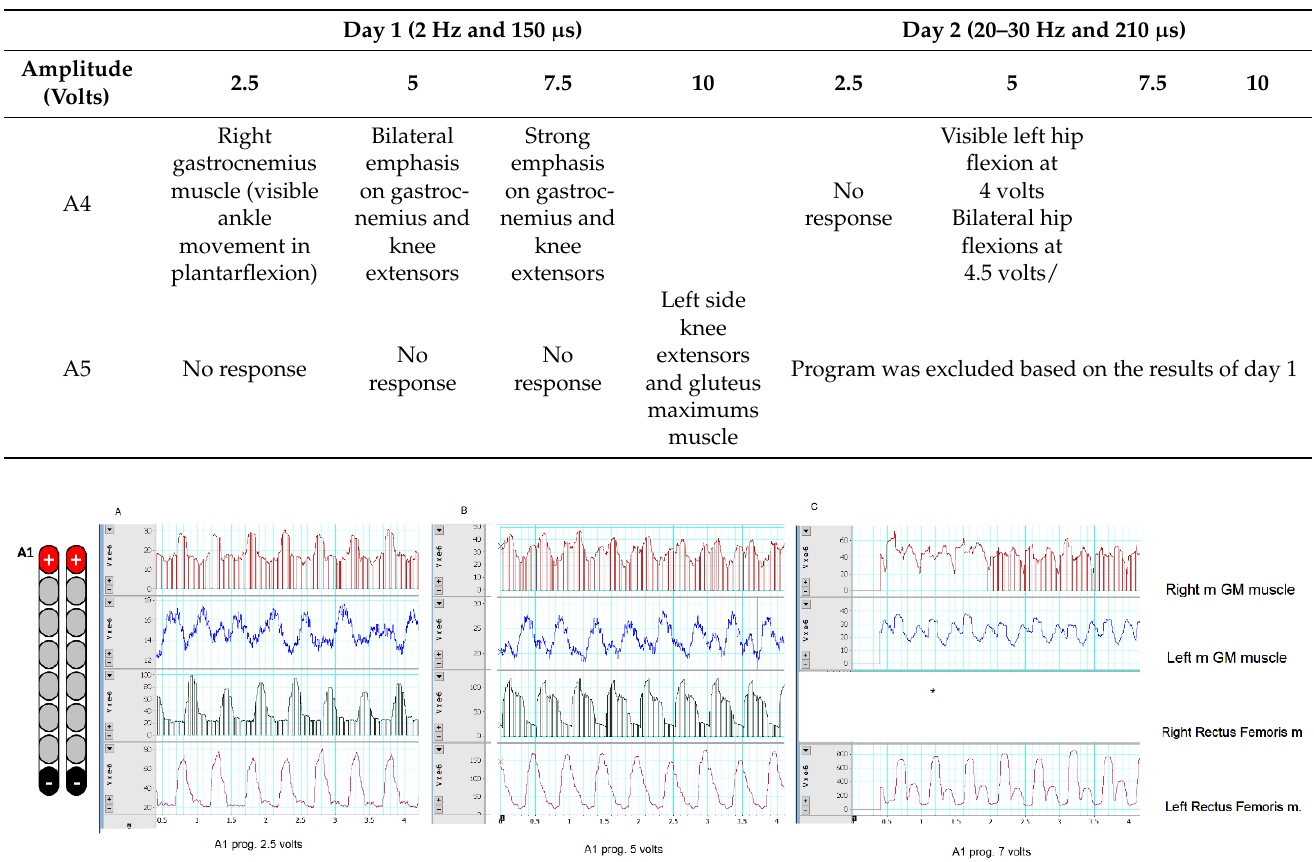
Figure 4. Representative EMG responses of rectus femoris (RF) m. and medial gastrocnemius (mGM) m. evoked by percutaneous scES. The EMG was tested at 2 Hz, 150 µs, and amplitude of current that progressed from 2.5 volts (visible EMG response without visible muscle contractions; ( A )), 5 volts (visible muscle twitches; ( B )), and 7.5 volts (strong visible twitches; ( C )). The EMG data were presented in a filtered format to highlight the distinct responses for both muscle groups. The A1 program was used as a part of Sayenko’s approach before detecting the migration of the left lead. Our results are in agreement with previous findings that noted that the voltage range of 3–8 volts resulted in biased and non-selective stimulation of the RF and mGM muscles. Note the EMG magnitude of rectus femoris m. compared to the medial GM muscle. *, EMG recordings of the right RF muscle was not recorded at 7.5 volts due to a technical error.